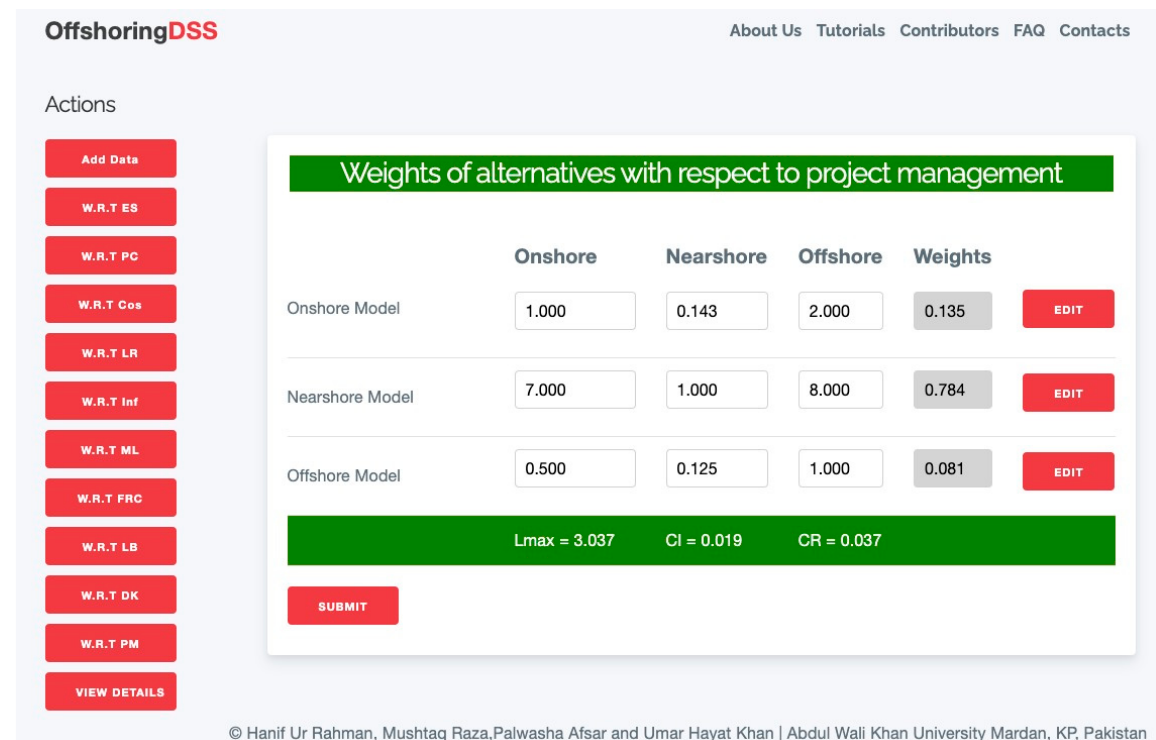
Figure A9. Alternatives weights with reference to PM and CR.